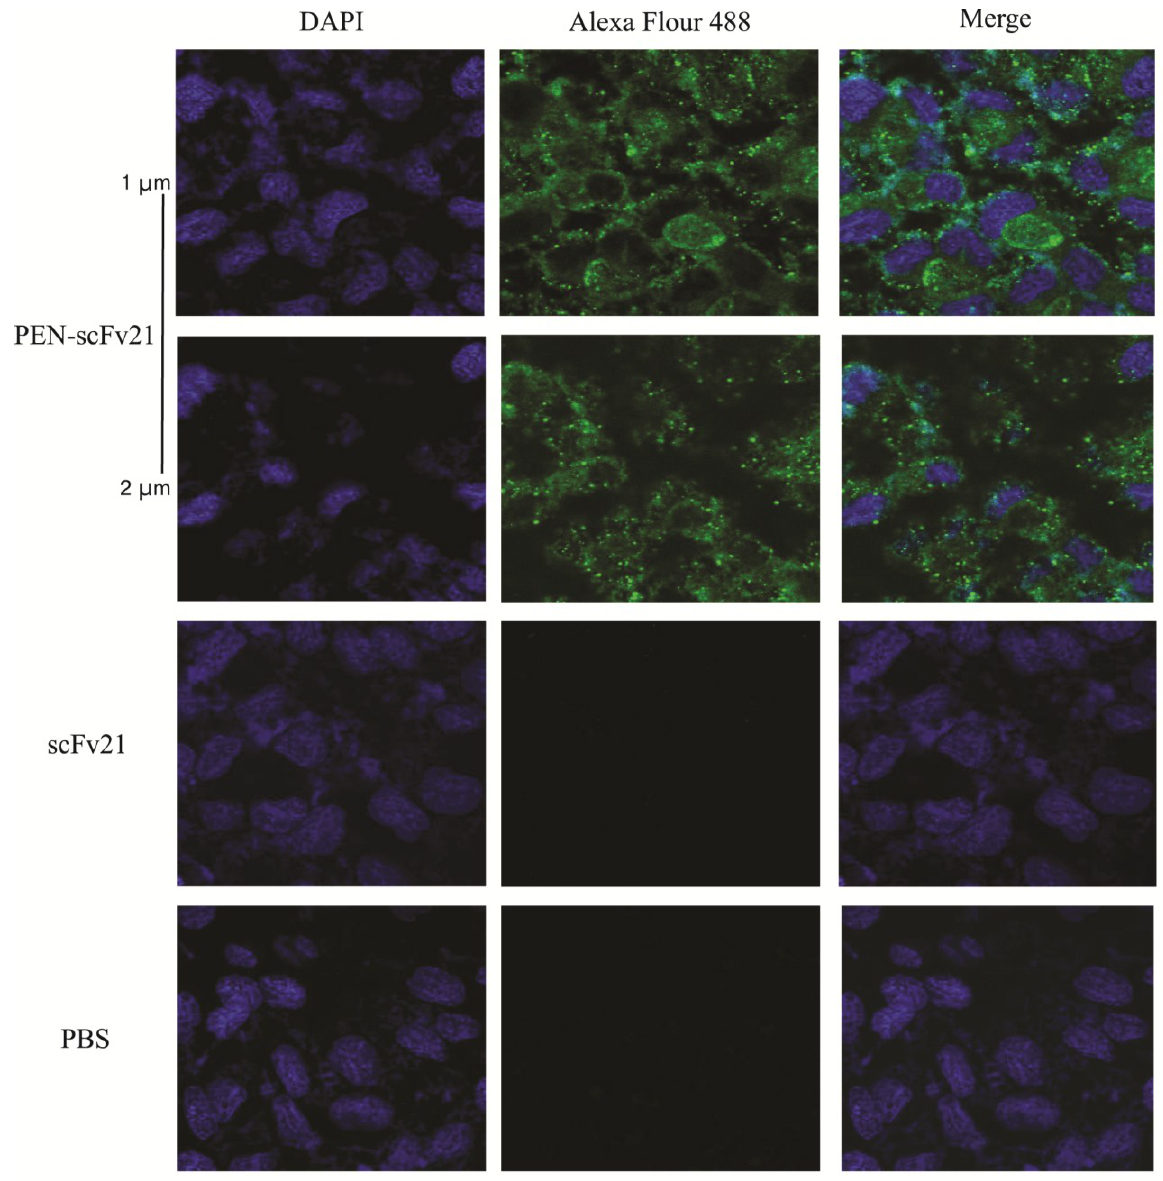
Figure 2. Intracellular localization of the penetratin (PEN)-scFv21 in MDCK cells revealed by laser sectional fluorescent confocal microscopy. The two upper rows, sections of MDCK cells (1 and 2 µm from the surface, respectively) incubated with PEN-scFv21; the third and the bottom rows, cells incubated with scFv21 and PBS, respectively. Left, middle and right panels of all rows, the cells were stained with DAPI for nuclei (blue), mouse monoclonal anti-6 × histidine tag and Alexa Flour 488 for PEN-scFv21 (green fluorescence) and merge,